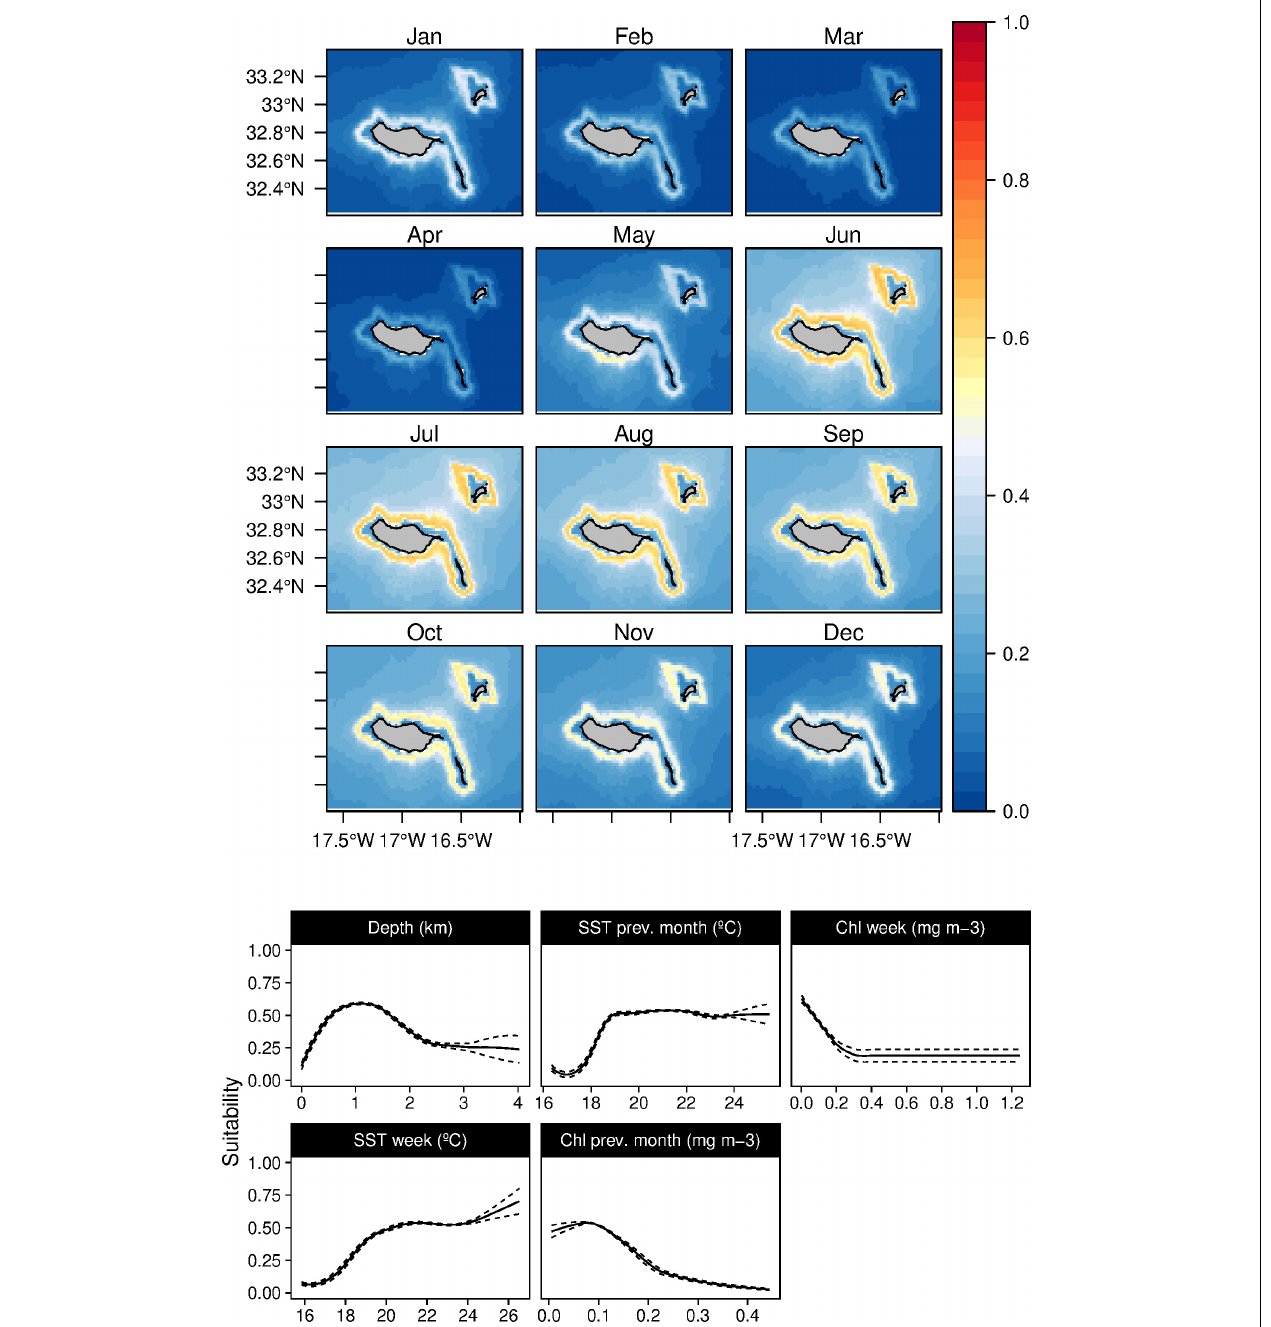
FIGURE 7 | Mean monthly suitability maps (above) and smoothed response curves with standard deviation (below) in the Madeira archipelago for Stenella frontalis for the “8-days” models. In the maps, red represents more suitable and blue less suitable. Responses curves are ordered by percent contribution of the environmental